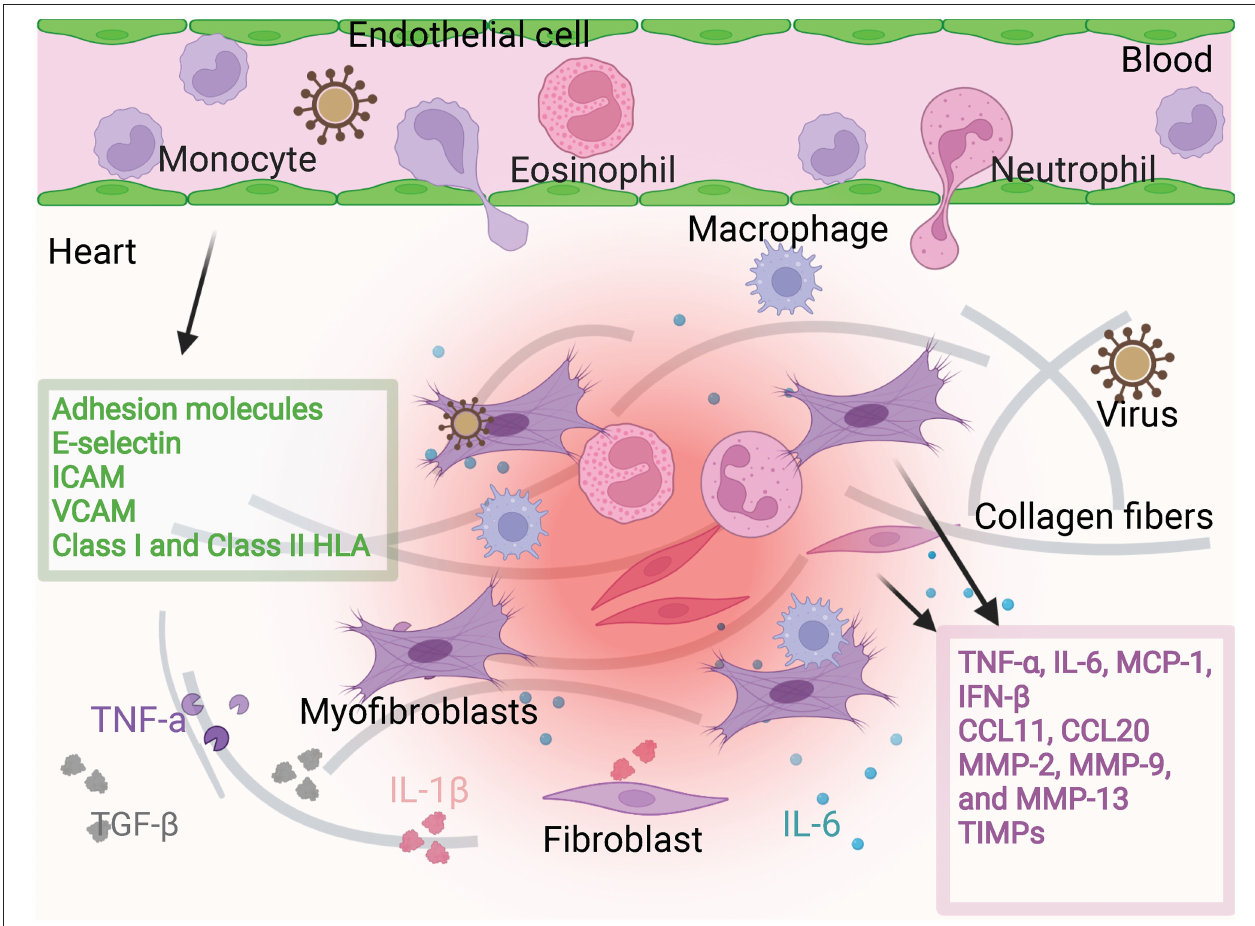
FIGURE 1 | Fibroblast and endothelial cell activation. Fibroblasts are activated in viral infection or in the environment containing cytokines. Then they produce pro-inflammatory factors and chemokines such as TNF- α , IL-6, MCP-1, IFN- β , CCL11, CCL12. They can also produce MMP family proteins to regulate cardiac interstitial fibrosis. Under the stimulation of these microenvironments, endothelial cells produce adhesion molecules to regulate the adhesion and infiltration of inflammatory cells. The participation of fibroblasts and endothelial cells promotes more severe cardiac inflammatory infiltration and more severe